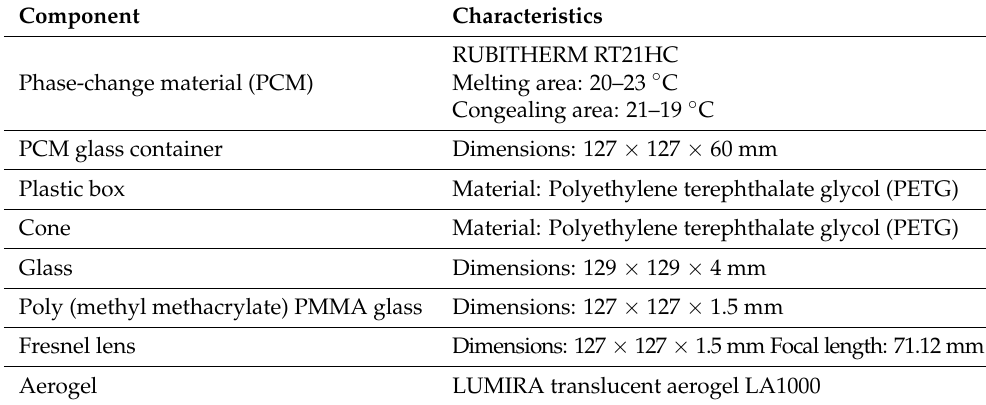
Table 2. Components of the solar facade model.